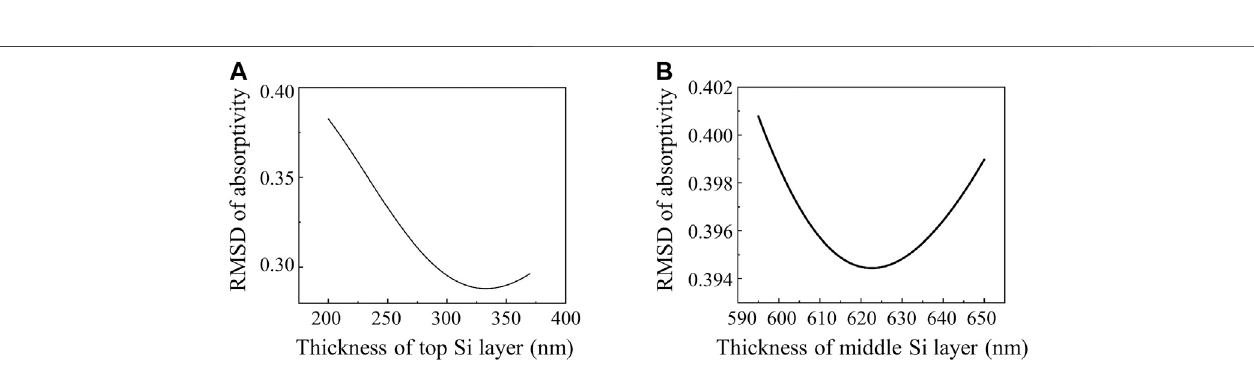
Figure 1B . Based on the impedance matching principle, the addition of Si dielectric spacer adjusted the wavelength- selective absorptivity. Within a certain spectral range, the impedance of a structure matches the impedance of air (the real part of impedance close to 1 and imaginary part close to 0); the incident electromagnetic waves can enter the structure instead of being re fl ected on the surface. The impedance can be calculated by Eq. 2 .